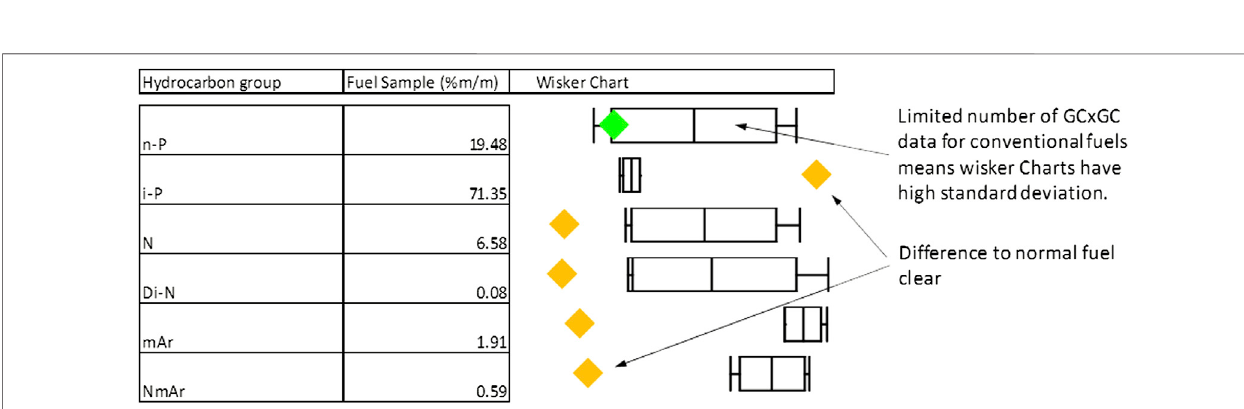
Frontiers in Energy Research |